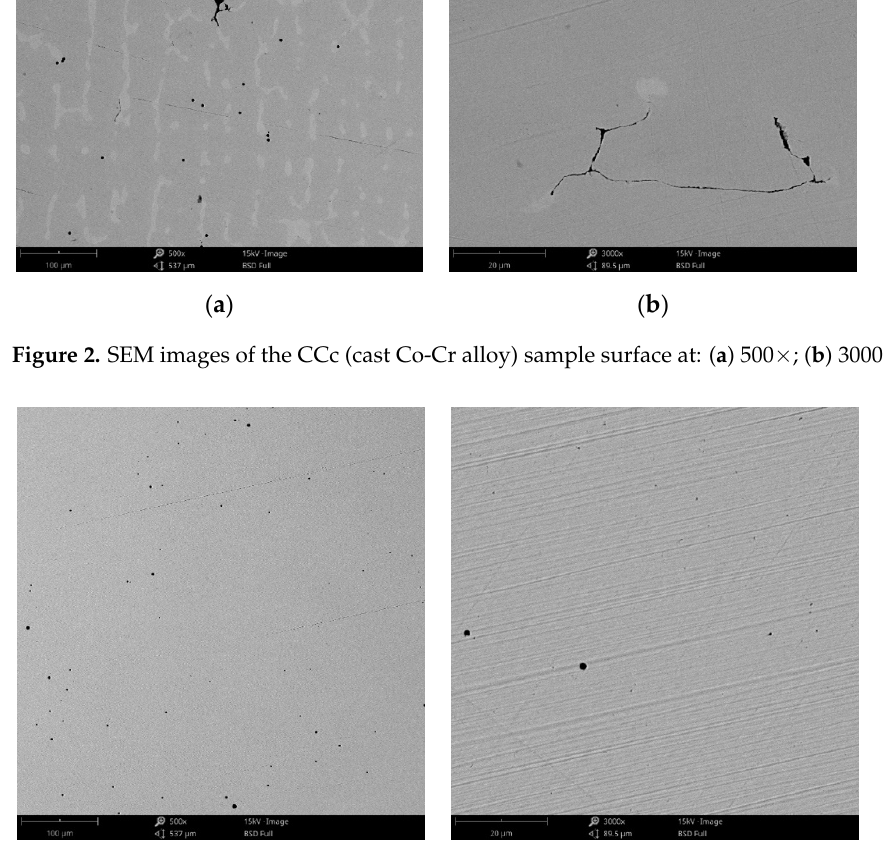
100.00 Figure 4. EDS spectra and elemental distribution for CCc samples.